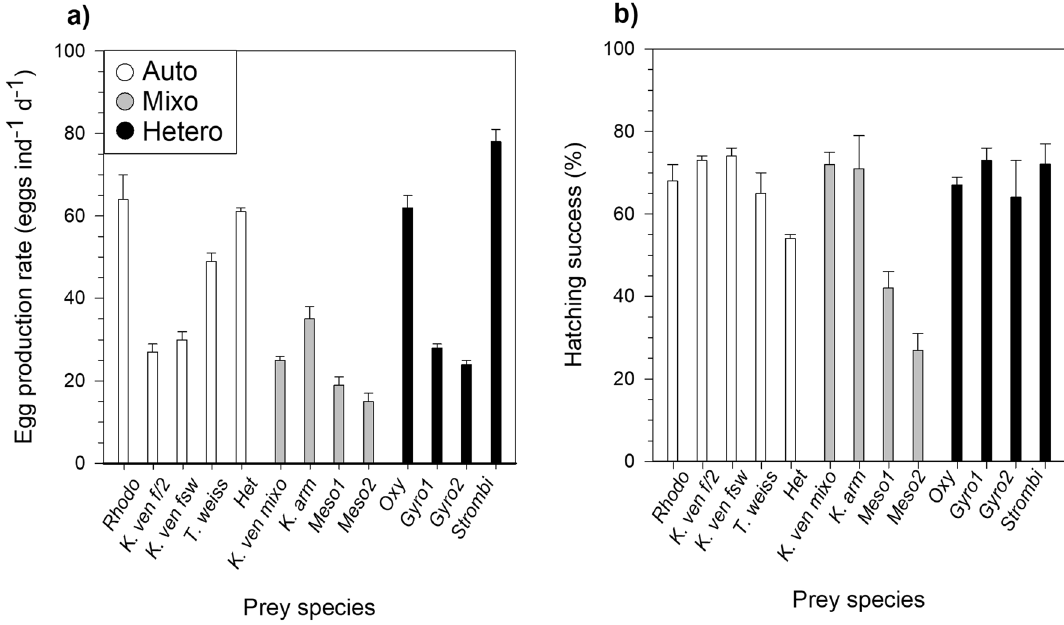
Figure 4. Reproduction and recruitment in the different dietary treatments. ( a ) P. grani egg production rate and ( b ) egg hatching success after 48 h from collection. Error bars are ± 1 s.e.m.